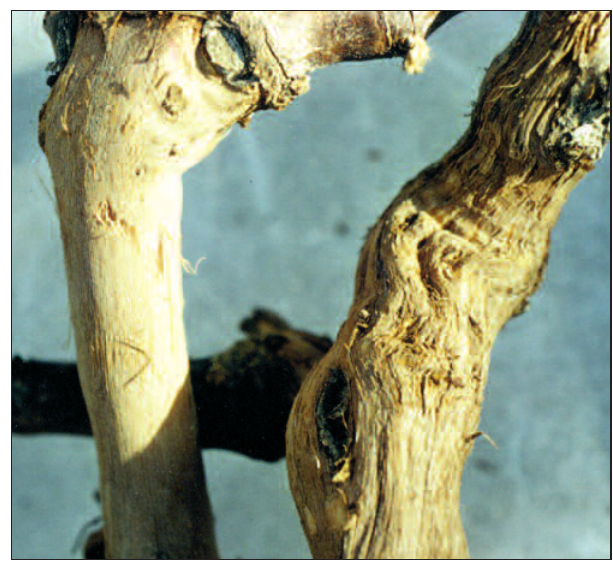
Figure 12 . LN stem grooving (LNSG) symptoms on LN 33 (right) and healthy controll